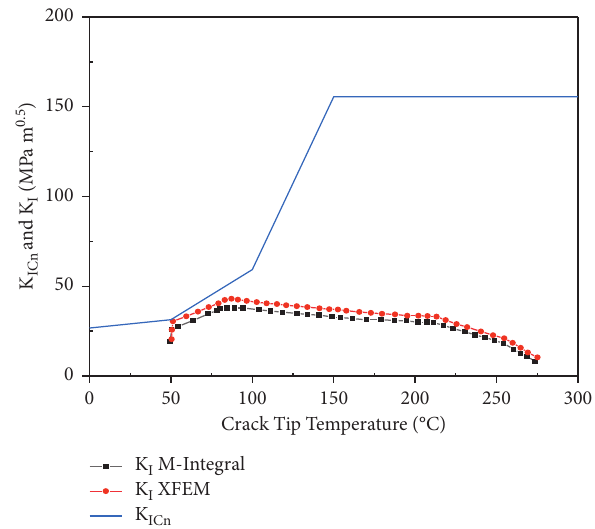
Figure 20: Comparison of K